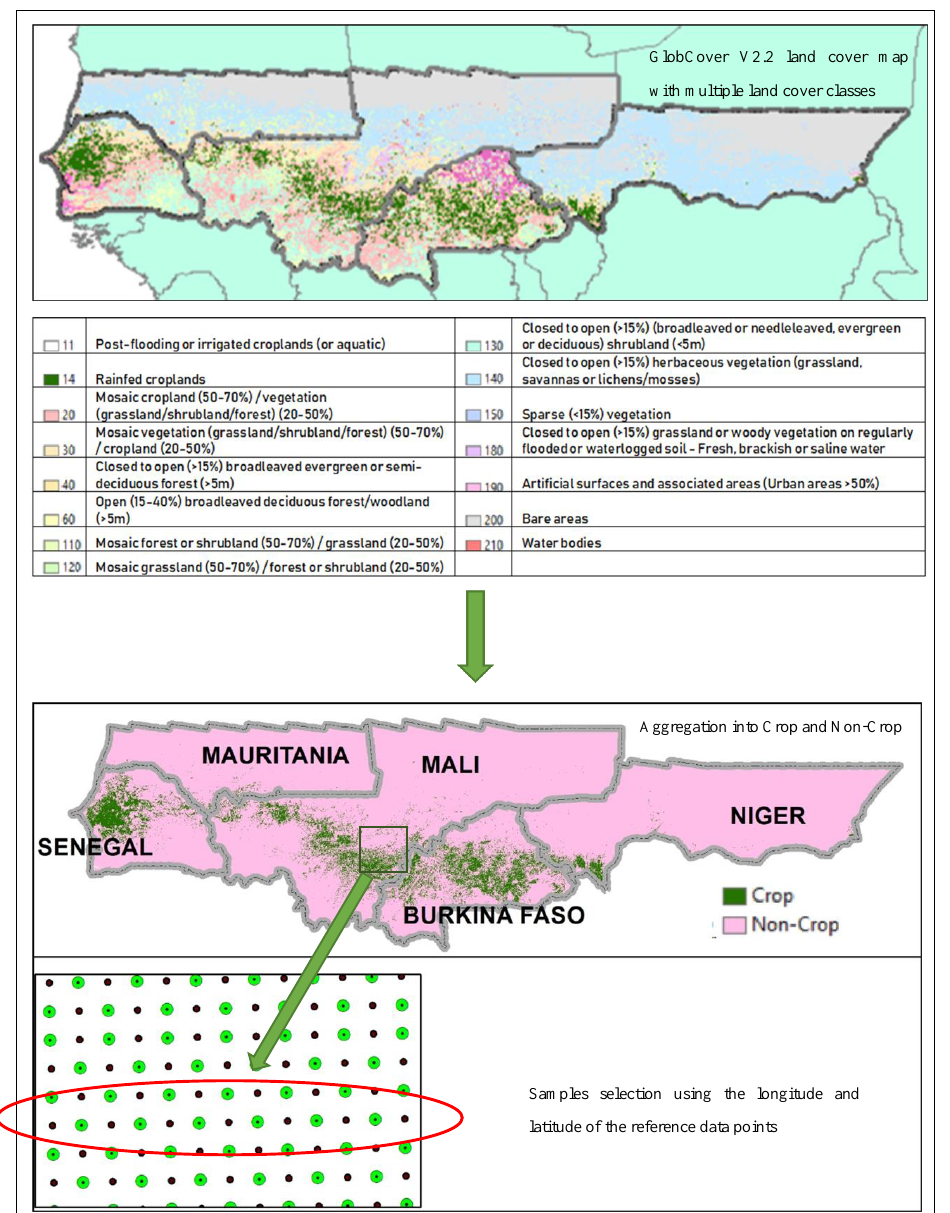
Figure 2. Example of the GlobCover V2.2 land cover map, aggregated into crop and non-crop classes, and a sample selection for error assessments. The first step was to aggregate the land cover classes with respect to the presence of agricultural activity. The second step extracted land cover data based on latitude and longitude of the reference data set (sampling every second location; green